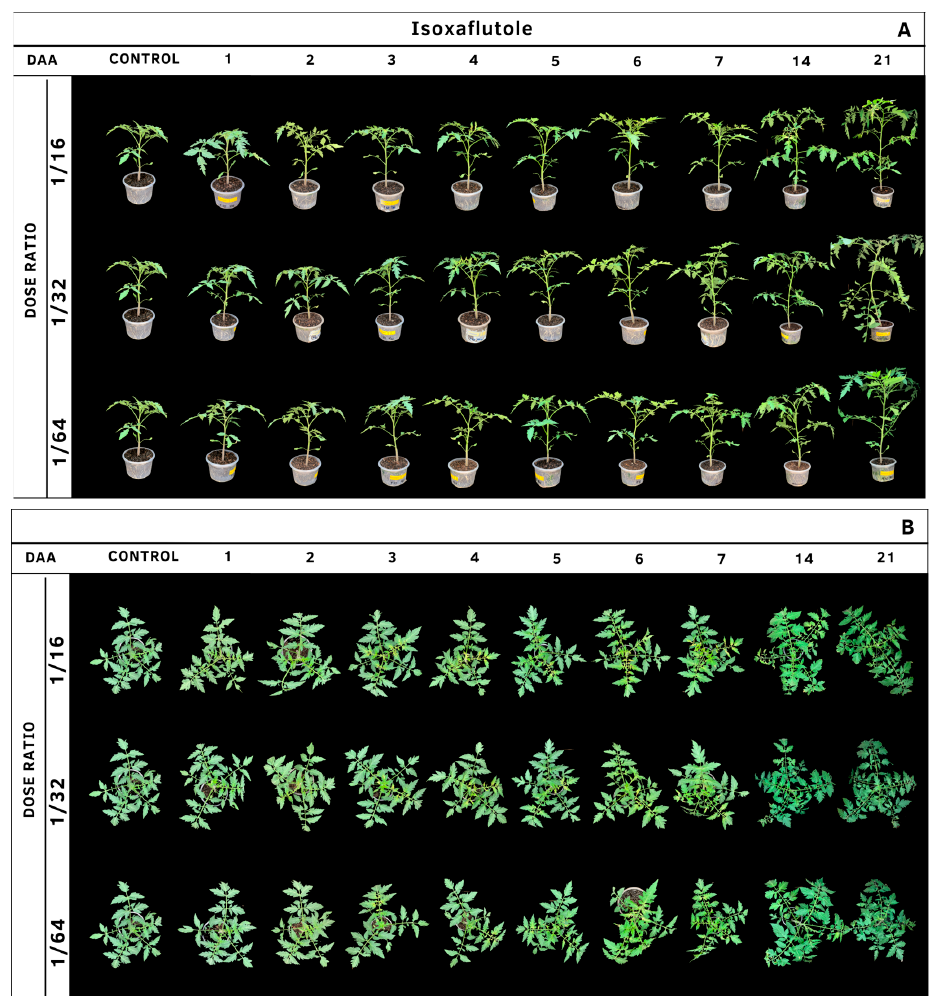
Figure 18. Symptoms evolution in tomato plants due to simulated isoxaflutole drift at dose ratios 1/16D, 1/32D, and 1/64D (16.41, 8.20, and 4.10 g a.i. ha − 1 , respectively) of the recommended dose (D). Evaluations were made from 1 to 7, 14, and 21 days after application (DAA). Front view ( A ) and top view ( B ) of tomato plants affected by simulated drift.